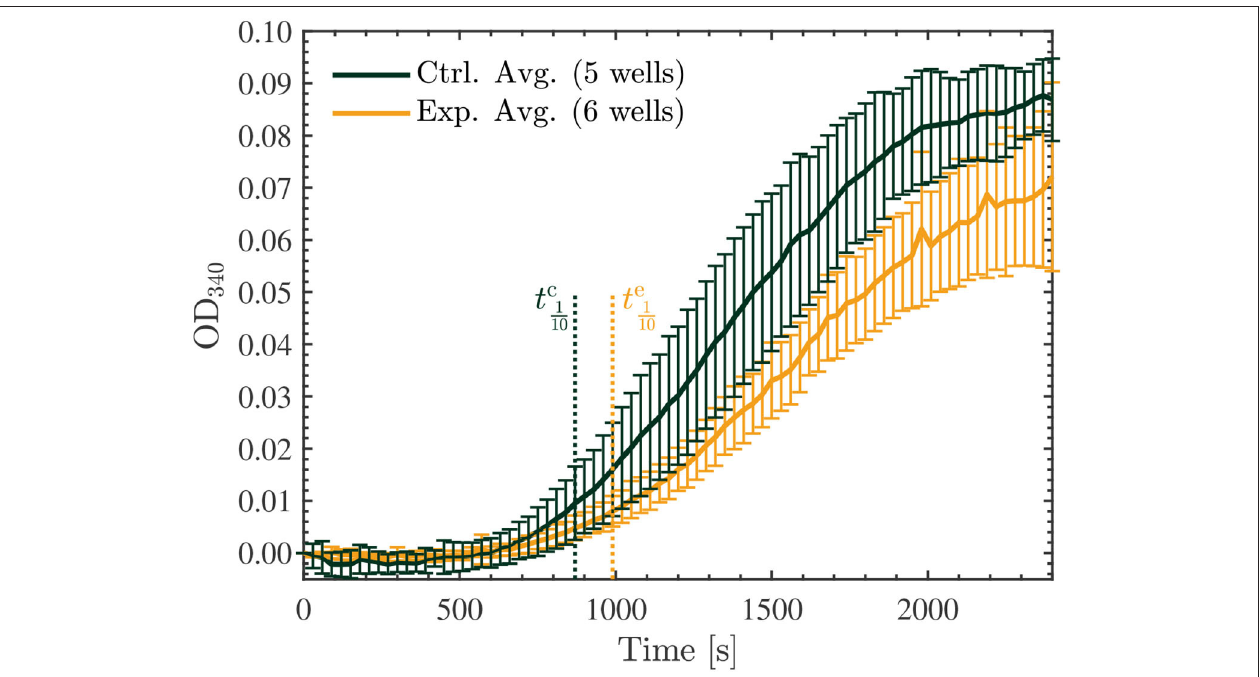
FIGURE 10 | Average optical density results of absorbance measurements performed at 340 nm, every 30 s for 40 min, on the 22.7 µ M control (green) and exposed (yellow) tubulin samples. The tenth times of t c 1 / 10 ≃ 870 s and t e 1 / 10 ≃ 990 s calculated for the control and exposed curves, respectively, are overlayed as the dotted vertical lines shown. The data presented was collected in N = 2 independent replicate experiments.